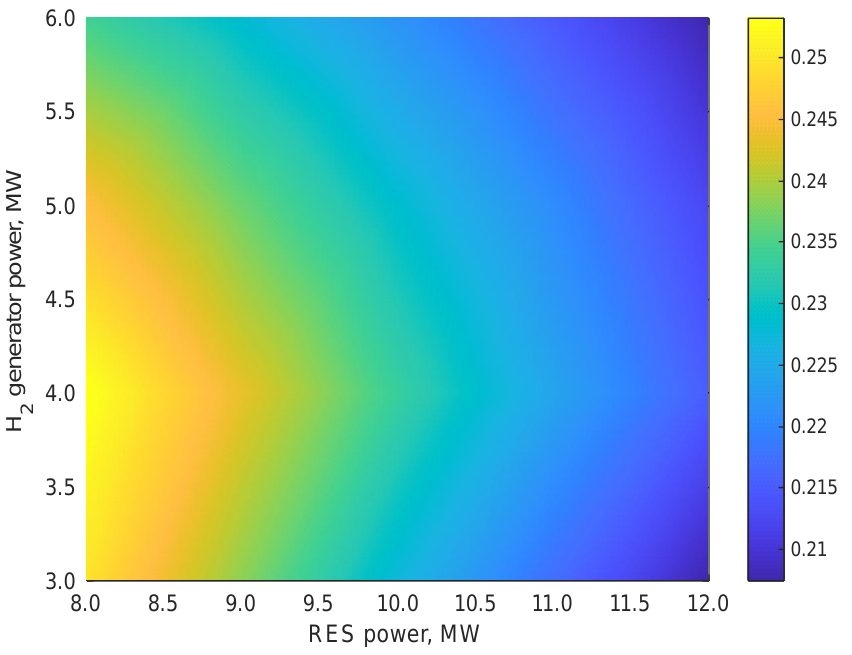
Figure 8. Plot showing the influence of the selected rated power of the renewable energy source and the hydrogen generator on the stored energy share factor, γ.